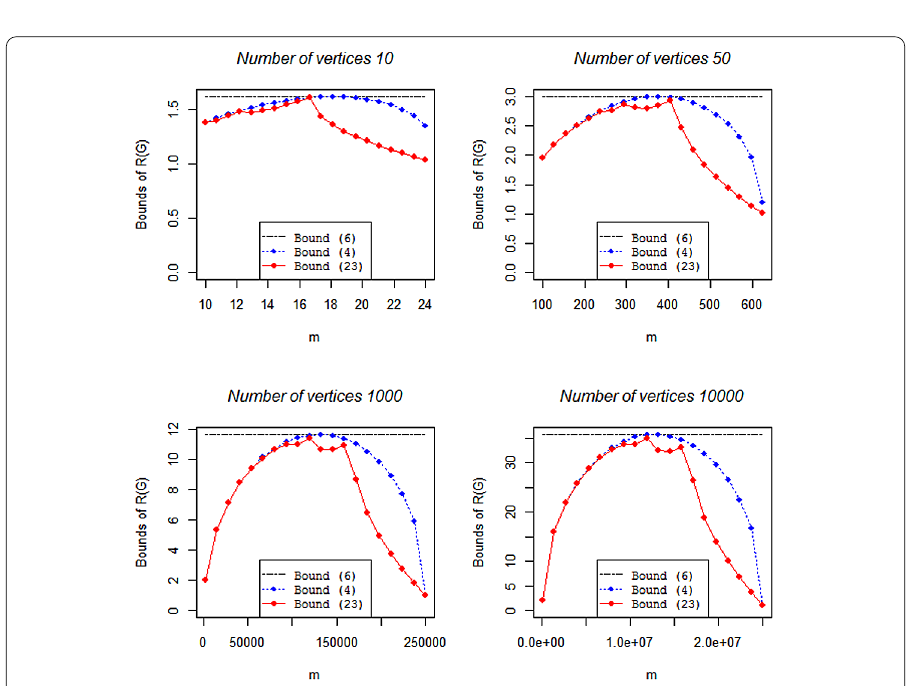
Figure 2 Upper bounds of R ( G ) for bipartite graphs with different number of vertices and edges.